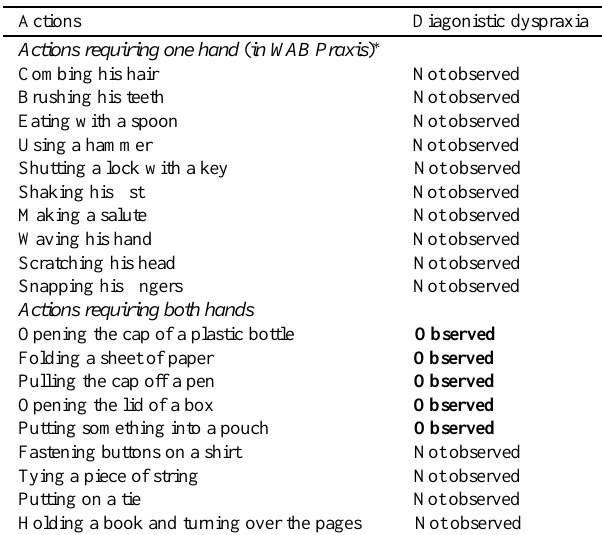
Table 3 Actions with and without diagonistic